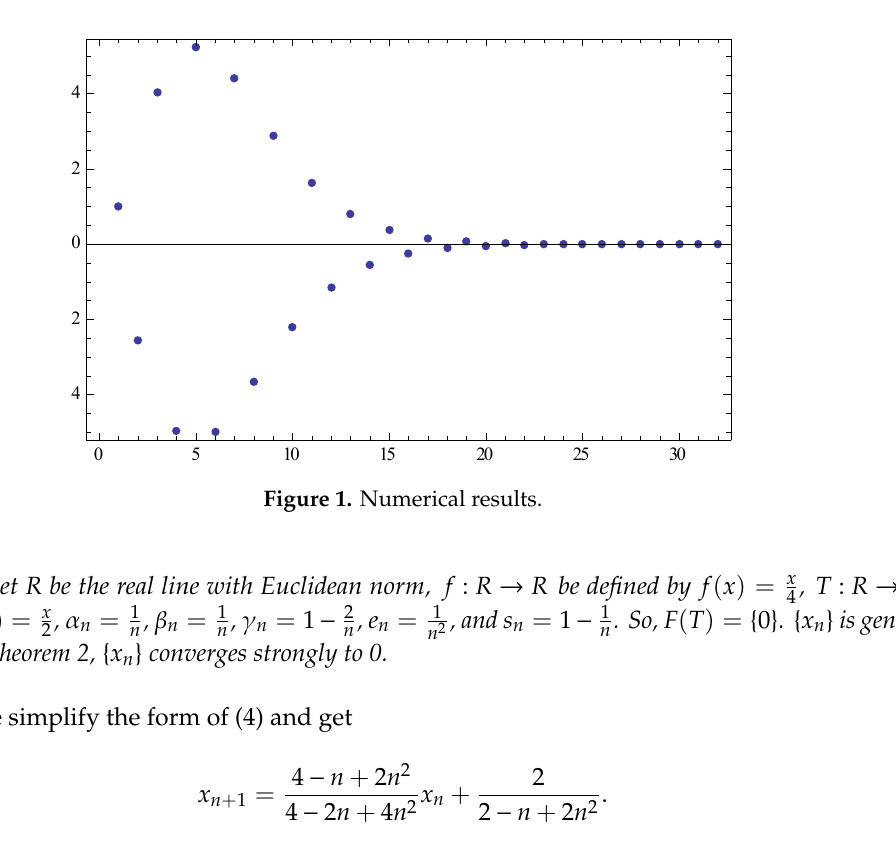
Figure 2. Numerical results. Example 3. Let